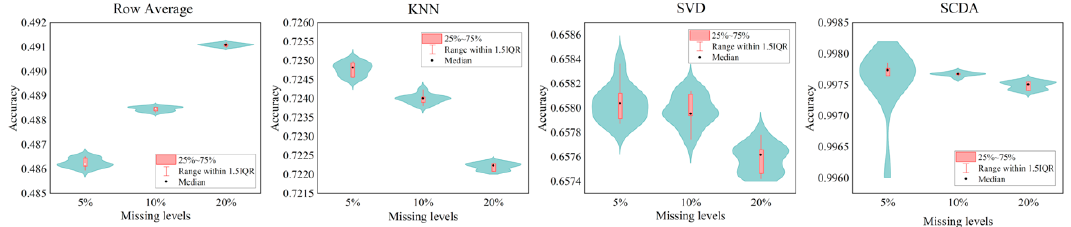
Figure 7. Violin plots of the accuracy values of different imputation methods on yeast genotypes at three missing levels. KNN, k-nearest neighbors; SVD, singular value decomposition.